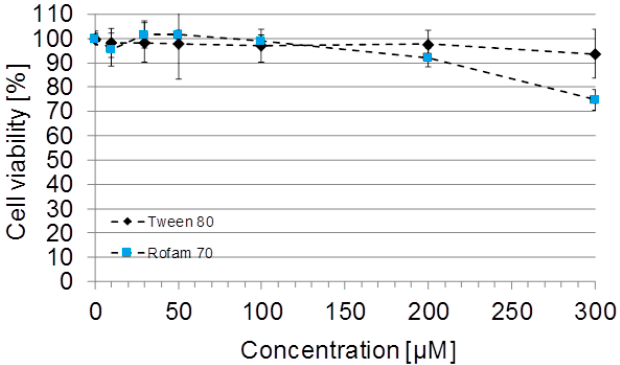
Figure 4. The effect of Rofam 70 and one of the tested positive controls, Tween 80 on A549 cell viability. Viable cells were quantified by water soluble tetrazolium salt (WST)-1 assay after 48 h of culture in the presence of the indicated compounds at concentrations ranging from 10 to 300 µM. Data is expressed as mean ± SD, n = 3.